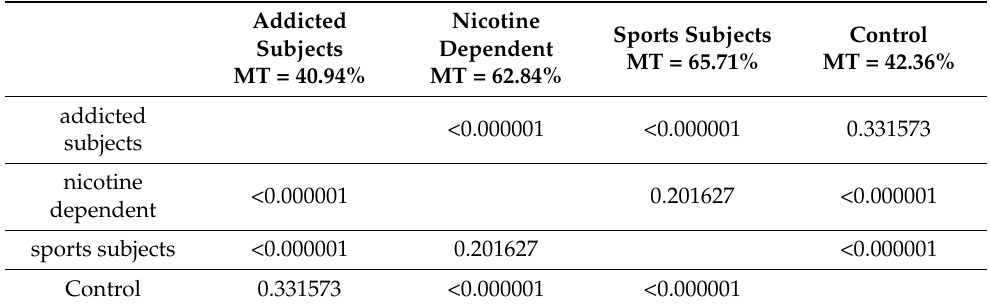
Figure 2. The relationship between total methylation sites (%) in a group of AS — addicted subjects, ND — nicotine-dependent subjects, S — sports subjects and C — controls. Mt — mean total methylation sites. SD — standard deviation. Table 3. Post hoc (Fisher LSD) analysis of dependencies between a group of addicted subjects, nicotine-dependent subjects, sports subjects and controls.